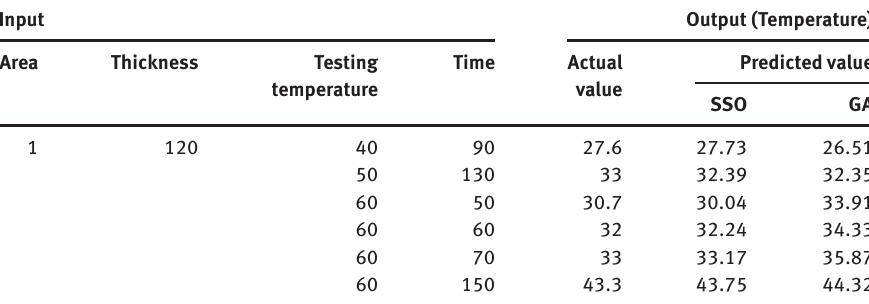
Table 4: Combined Two Ferro-Cement Wall Panels.